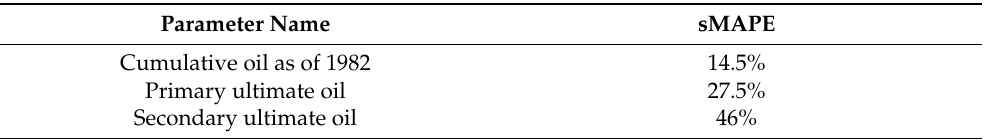
Table 3. Production curve accuracy estimation: symmetric Mean Absolute Percentage Error (sMAPE) for total cumulative production by 1982, primary ultimate oil and secondary recovery